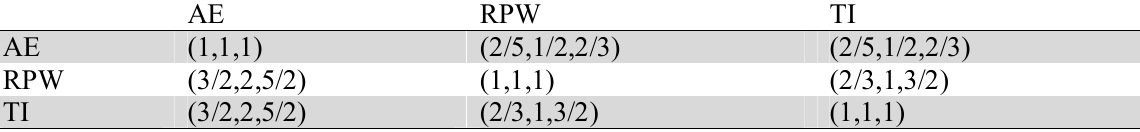
The Evaluation Matrix Relevant to the Academic Factor